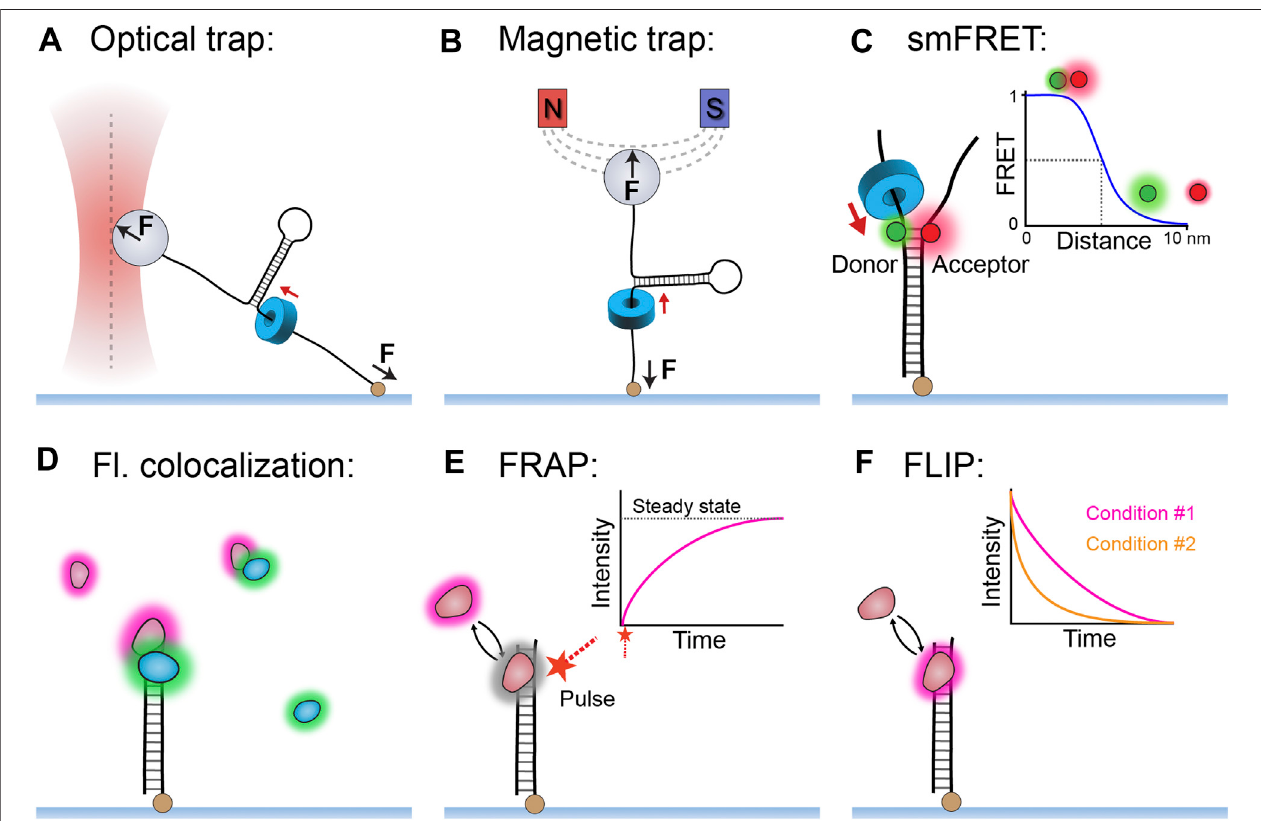
FIGURE1|Single-moleculemethods usedtostudyreplicativehelicases.(A) Anopticaltrap usesalasertoapplyapullingforce(0.5 – 100 pN)toadielectric bead,whichcaninturnapplyforcetoaDNAtemplateandmeasurechangesinDNAlengthduringhelicaseunwinding. (B) Amagnetictrapusesamagnetic fi eldtoapply force (10 – 100 pN) and torque to a paramagnetic bead and thus measure DNA length changes during helicase unwinding. (C) Single-molecule FRET can measure helicase unwinding through the changes in proximity of the donor and acceptor fl uorophores positioned within the DNA template. (Inset) The relationship between FRET ef fi ciency and distance between the fl uorophores. (D) The simple technique of multi-color colocalization is effective at detecting helicase interactions in complex reactions. (E) Single-molecule fl uorescence recovery after photobleaching (FRAP) method can be used to quantify protein exchange in the form of recovered fl uorescence following a deliberate bleaching event. (F) Single-molecule fl uorescence loss in photobleaching (FLIP) method can also detect protein exchange when comparing different fl uorescence lifetimes between conditions.